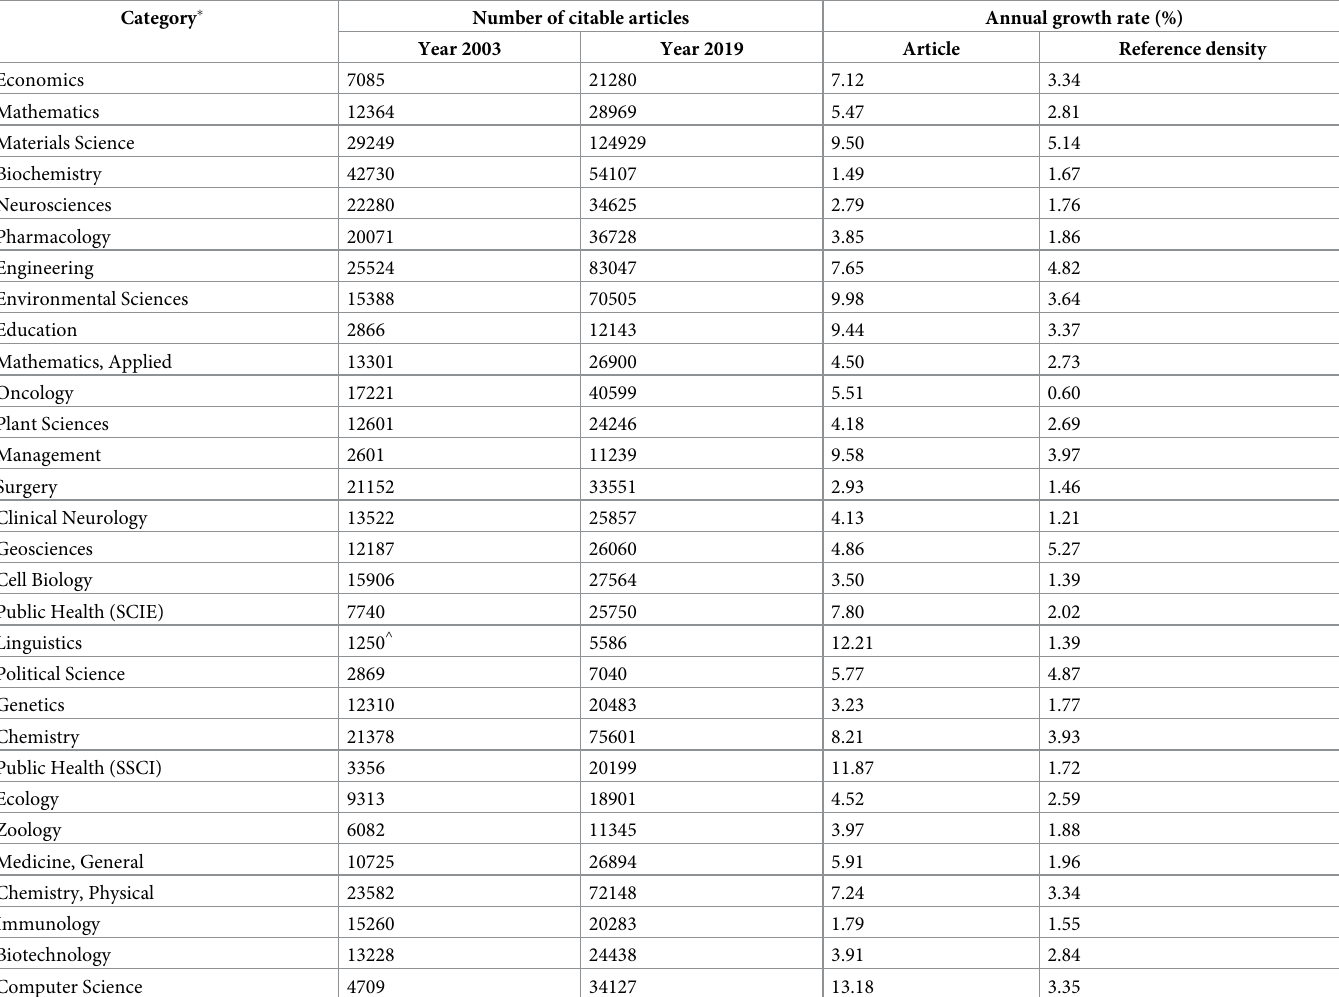
Table 4. Annual growth rate of citable articles from 2003 to 2019 in the top 30 disciplinary categories compared to that of reference density.